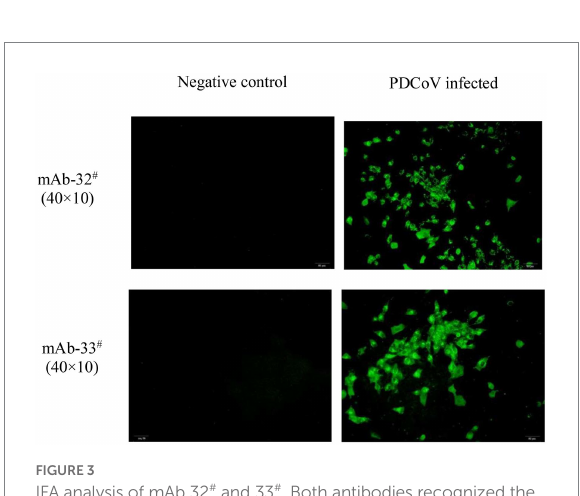
FIGURE 3 IFA analysis of mAb 32 # and 33 # . Both antibodies recognized the nucleocapsid protein in PDCoV-infected LLC-PK1 cells. The uninfected LLC-PK1 cells were used as a negative